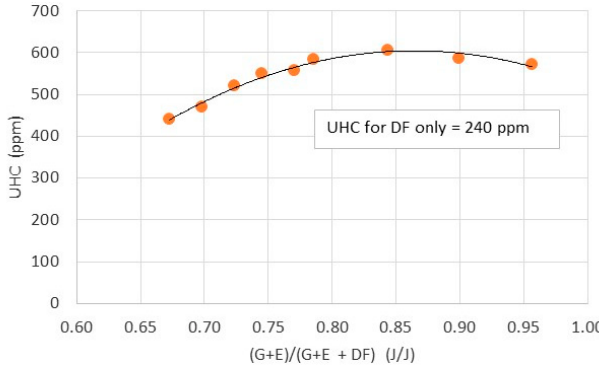
Figure 8. UHC vs. G + E fraction by energy content.